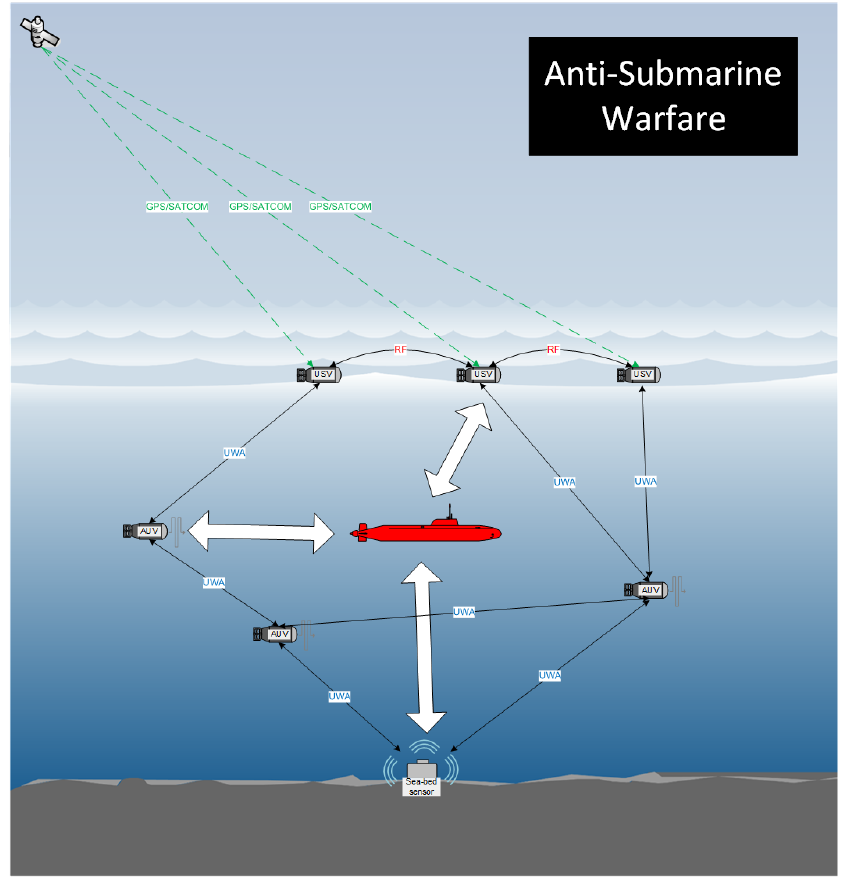
Figure 2. Anti-Submarine Warfare use case. A network of USVs identifies a hostile platform, and informs a remote command post via satellite